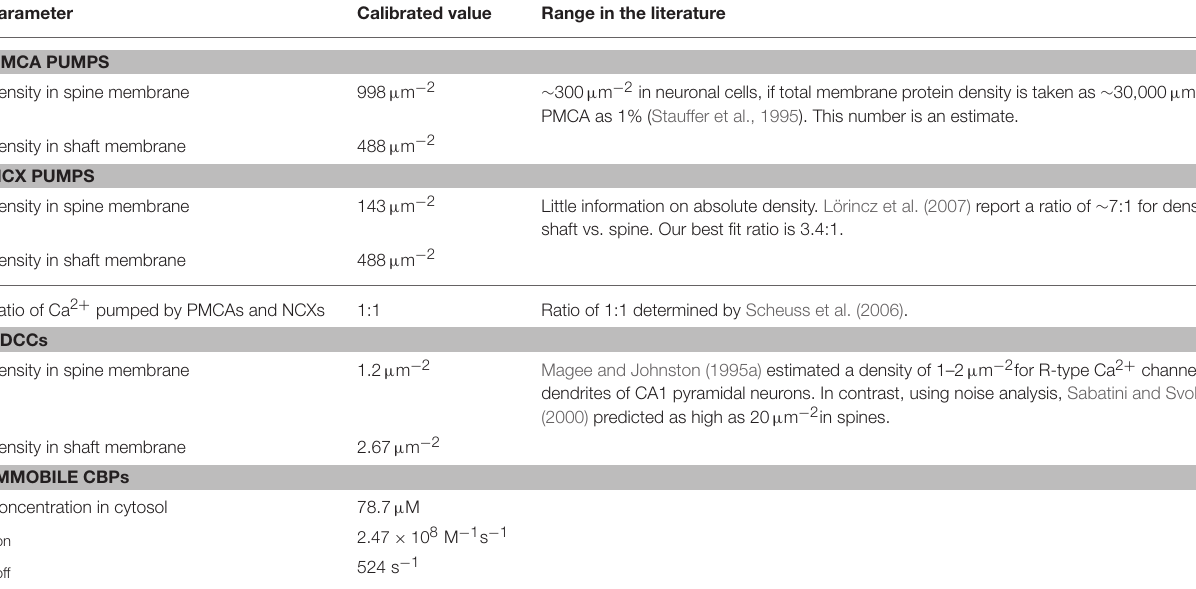
TABLE 3 | Calibrated